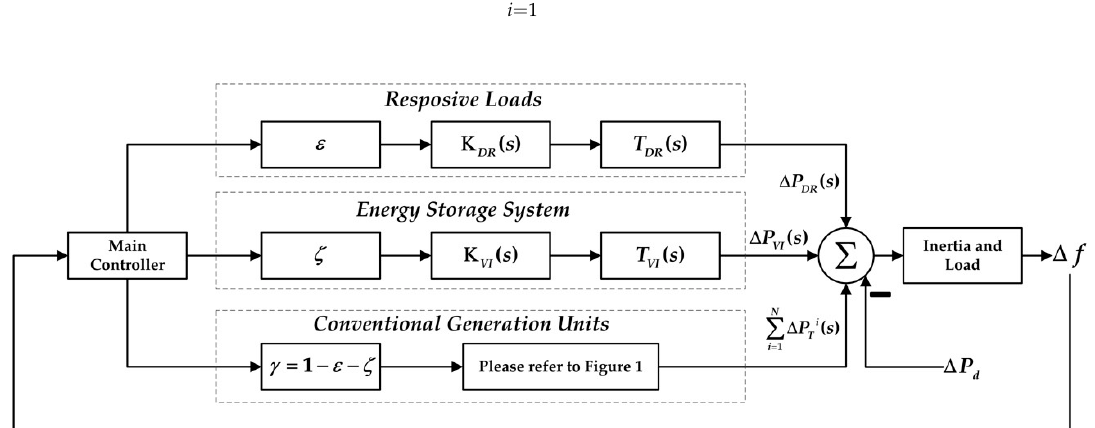
Figure 2. Model of a multi-machine power system augmented with responsive loads and virtual inertia from BESS.